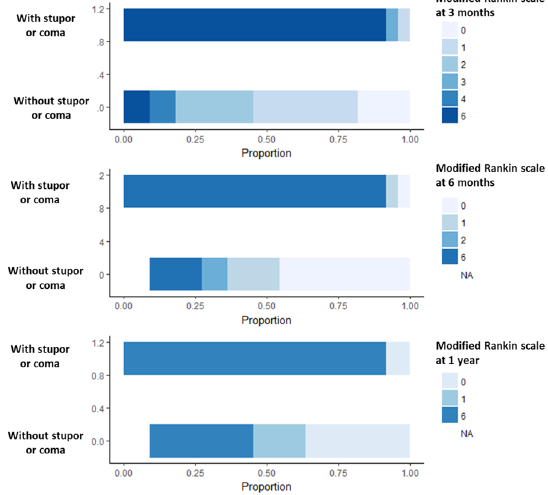
Fig. 1 Neurological outcome assessing by modified Rankin scale accord‑ ing to stupor or coma at intracranial hemorrhage diagnosis (blank reflect missing